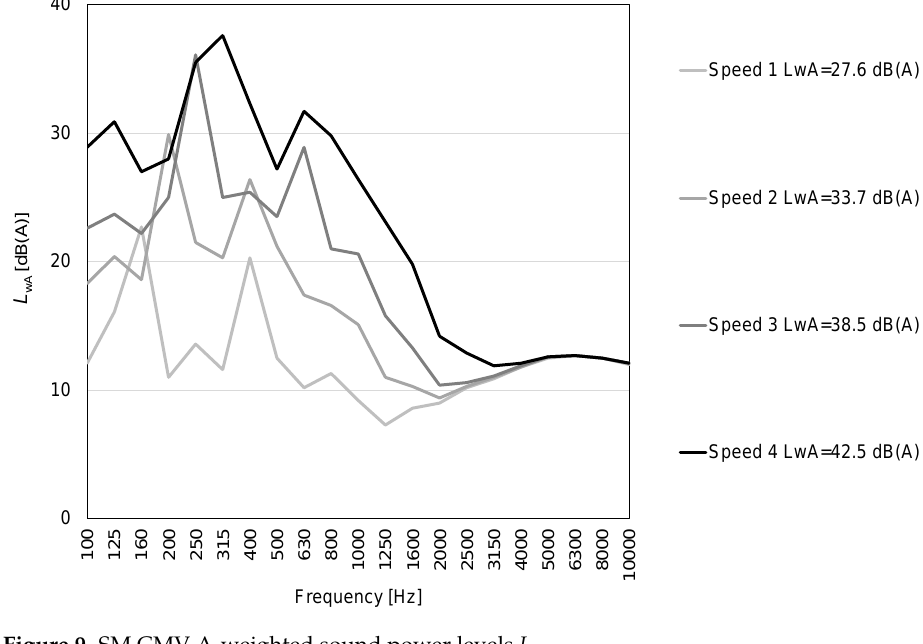
Figure 9. SM CMV A-weighted sound power levels L wA .